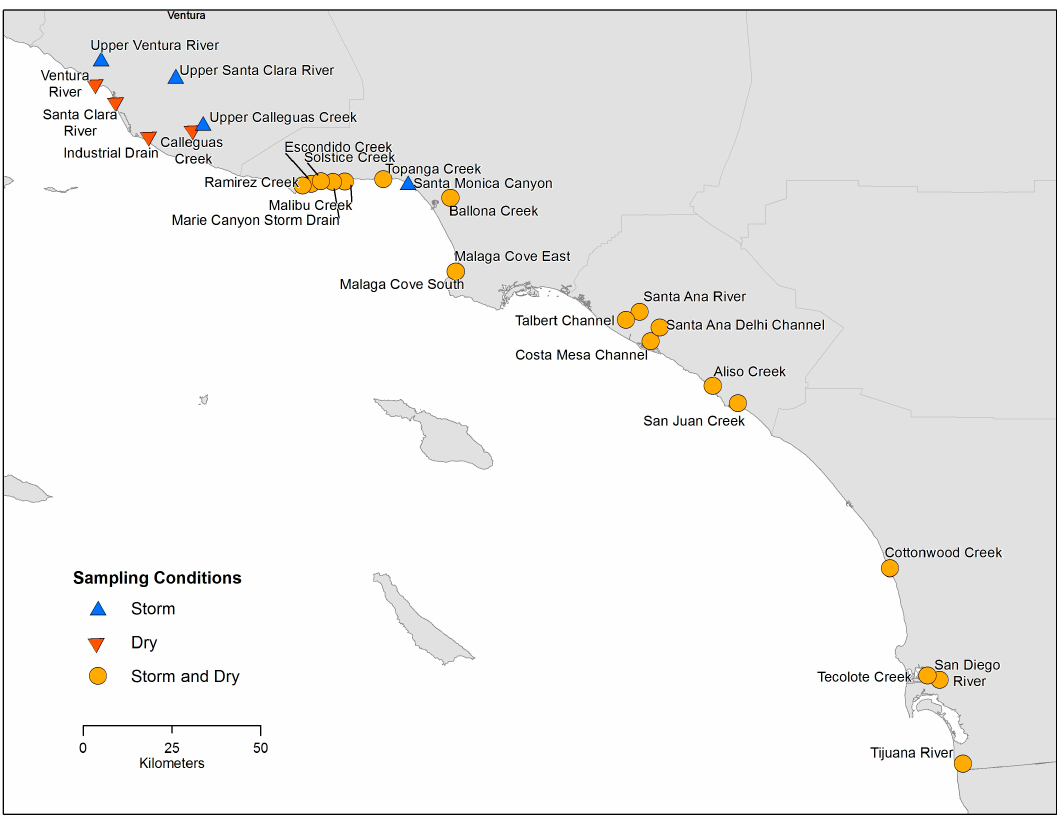
Figure 1. Sampling sites. The majority of the sites were sampled in both storm (i.e., wet weather) and summer dry conditions. An interactive map, including site photos, is available at http://bit.ly/2sxLHcI.